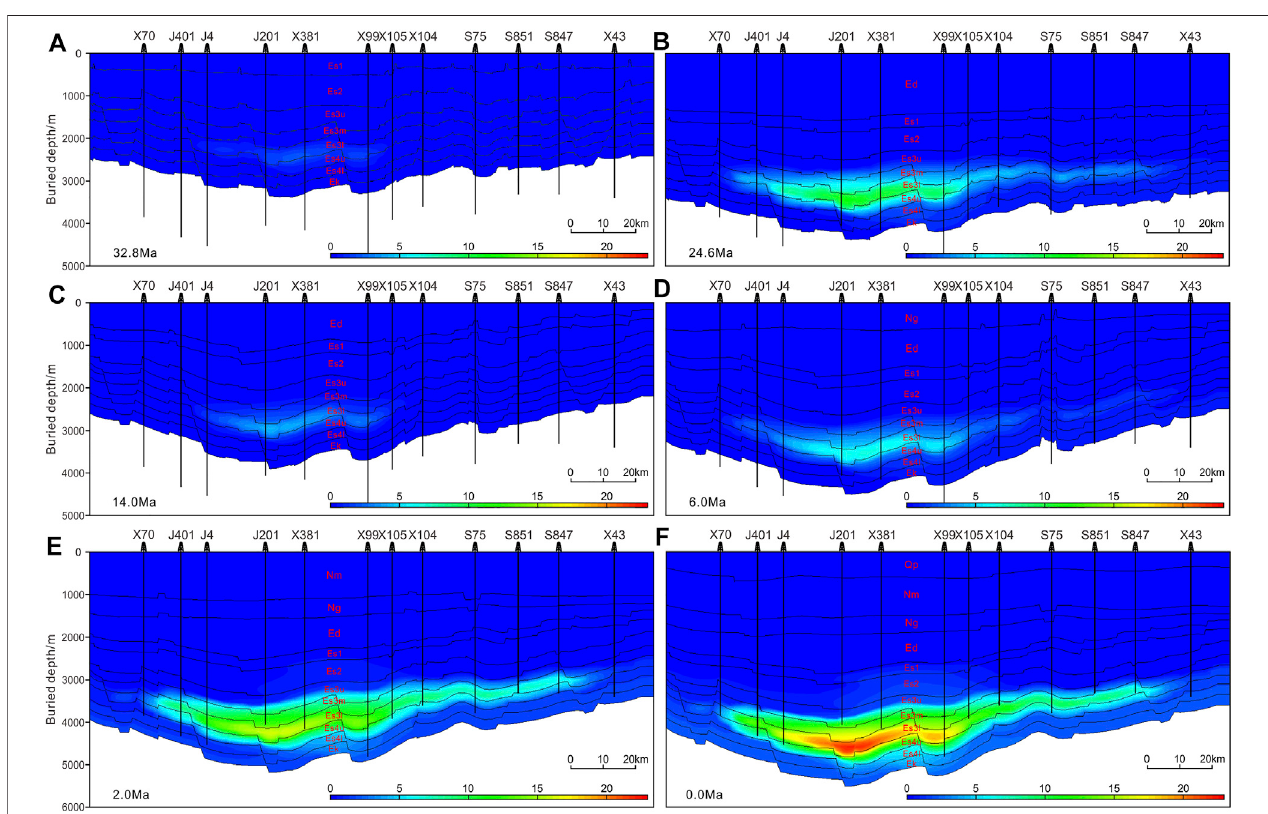
FIGURE 9 | Modeling results showing the overpressure evolution of a cross section in the Linnan Sag. (A) 32.8 Ma, (B) 24.6 Ma, (C) 14.0 Ma, (D) 6.0 Ma, (E) 2.0 Ma, (F) 0.0 Ma. The location of the section is shown in Figure 1 .